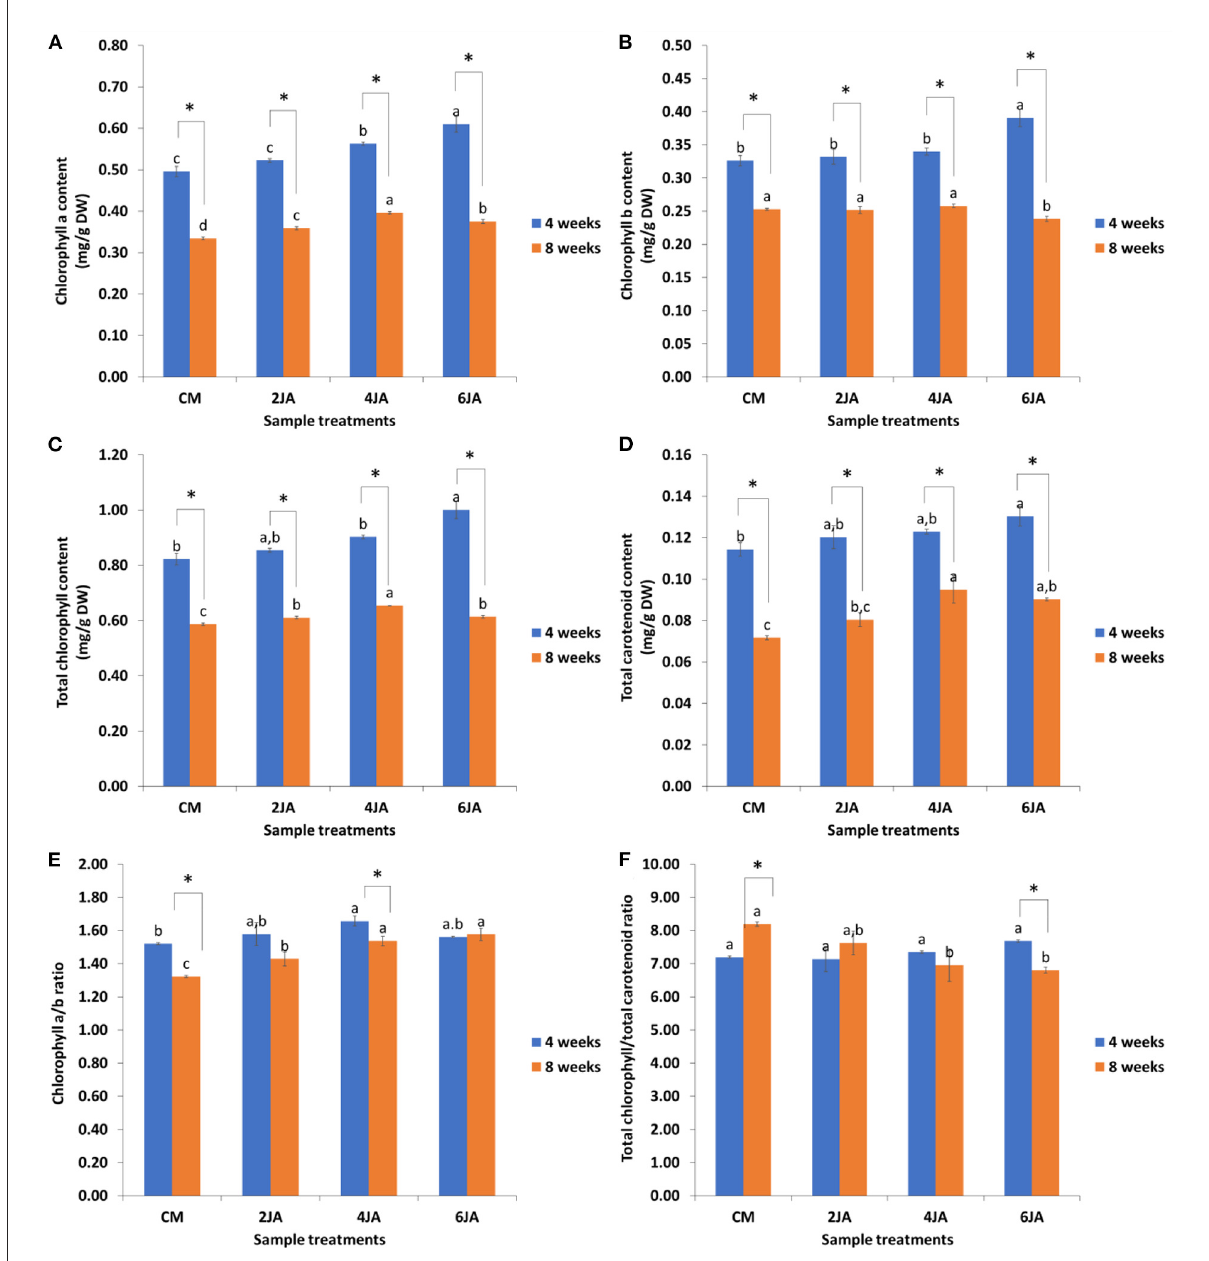
FIGURE3 Effect of different concentration of jasmonic acid on (A) chlorophyll a, (B) chlorophyll b, (C) total chlorophyll, (D) total carotenoid, (E) ratio of chlorophyll a to chlorophyll b, and (F) ratio of total chlorophyll to total carotenoid in 4 and 8-week-old A. indica green callus. Data expressed as mean values ± standard error (SE) of three replicates. Treatment bars denoted with different letters (subject to samples’ age) are significantly different at p ≤ 0.05 according to Duncan’s multiple range test (DMRT), while * denotes significant difference between samples’ age (at p < 0.05) according to Student’s t -test. CM , callus induction media composed of 0.6 mg/L TDZ; TDZ , thidiazuron; JA , jasmonic acid.